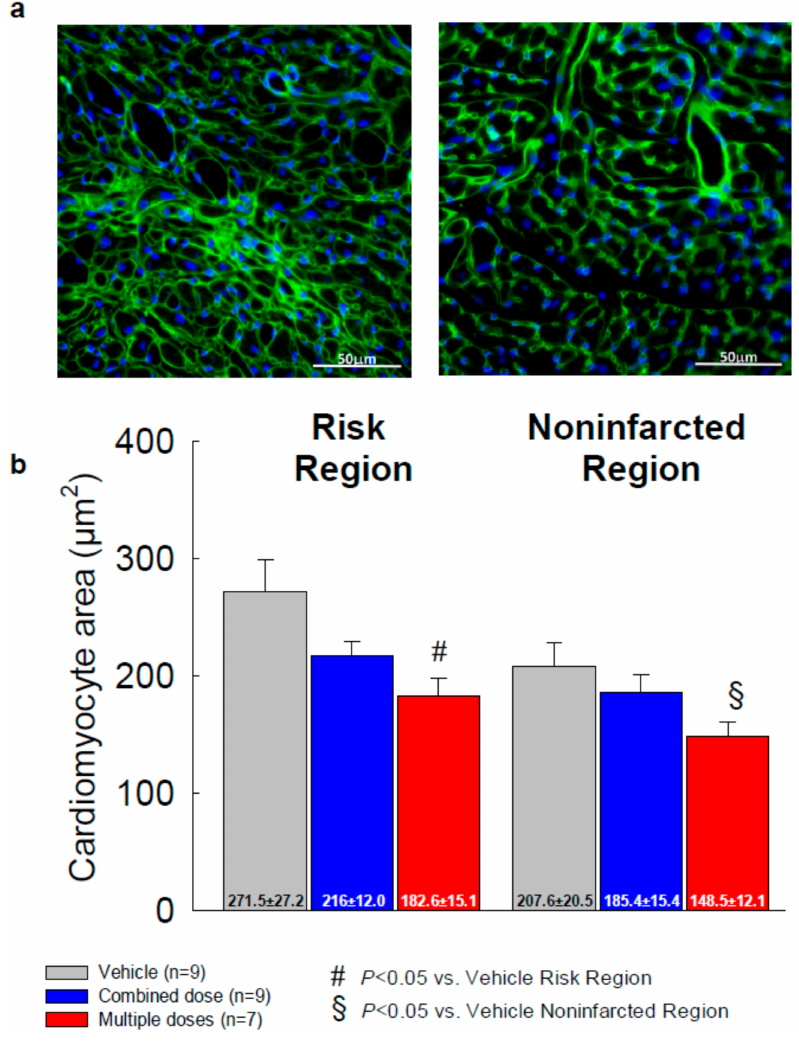
Figure 6. Analysis of the cross-sectional area of cardiac myocyte ( n = 7~9/group). Myocyte cross- sectional area was assessed by immunostaining of cardiac myocytes with DAPI (blue) and WGA (green) to facilitate identification of cell membranes. ( a ) Representative microscopic images of WGA-stained LV sections; ( b ) quantitative analysis of myocyte cross-sectional area in the risk and noninfarcted regions. All data are represented as the mean ±